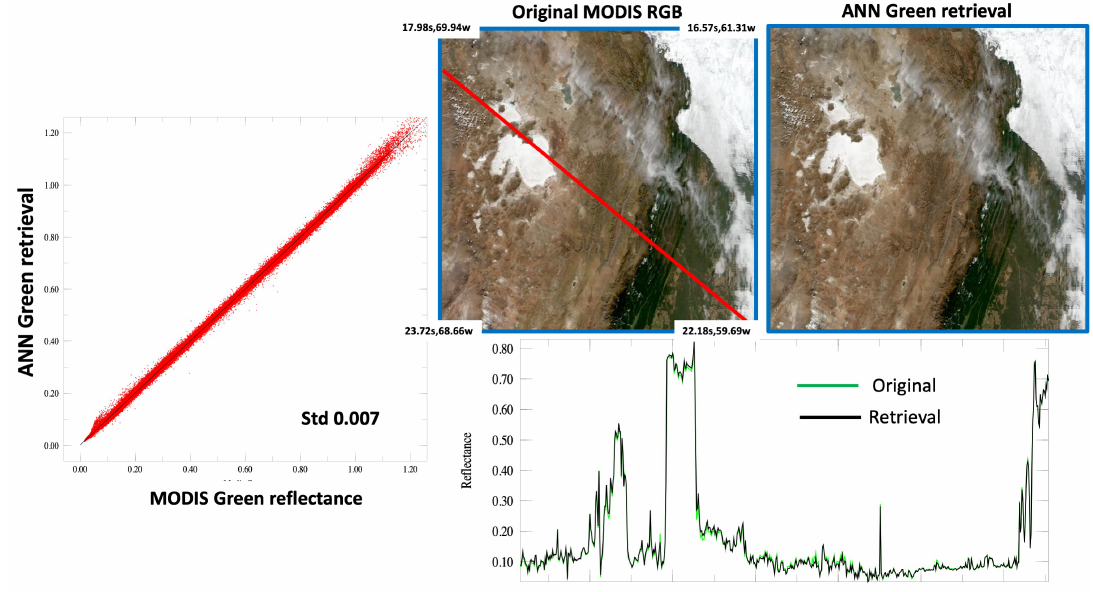
Figure 10. Illustration of the green reconstruction over the South American red-selected area in Figure 8. The left image is a RGB MODIS granule; the right image is the same but using the ANN reconstructed green band. The green and black curves represent the green reflectances across the red marked transects, for the original and reconstructed images, respectively.